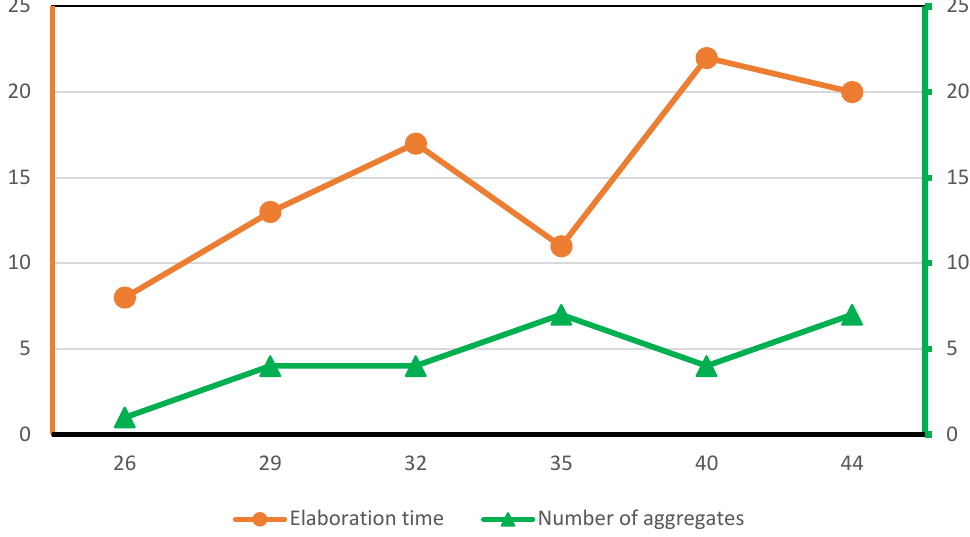
Figure 16. Elaboration time and number of aggregates as a function of the required power variation.